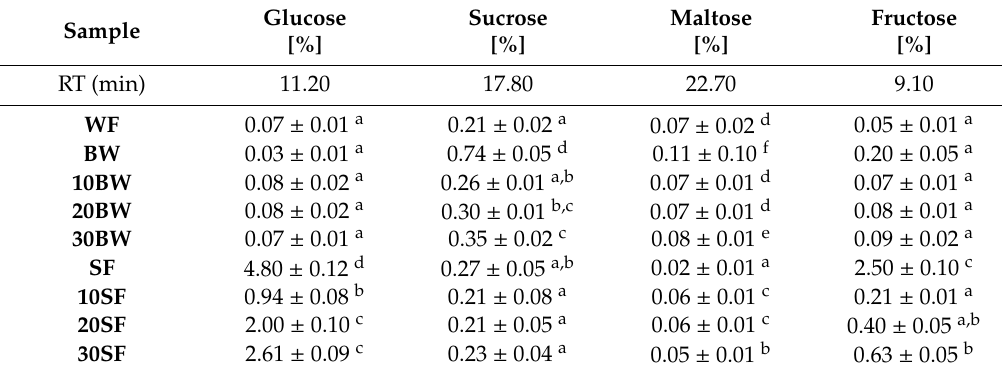
Table 4. Free sugars content of flour